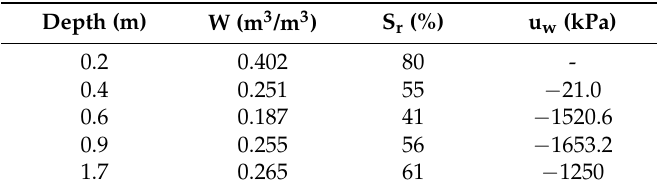
Table 3. In situ characteristics of Costa Cavalieri test-site (9 November 2017) 1 .